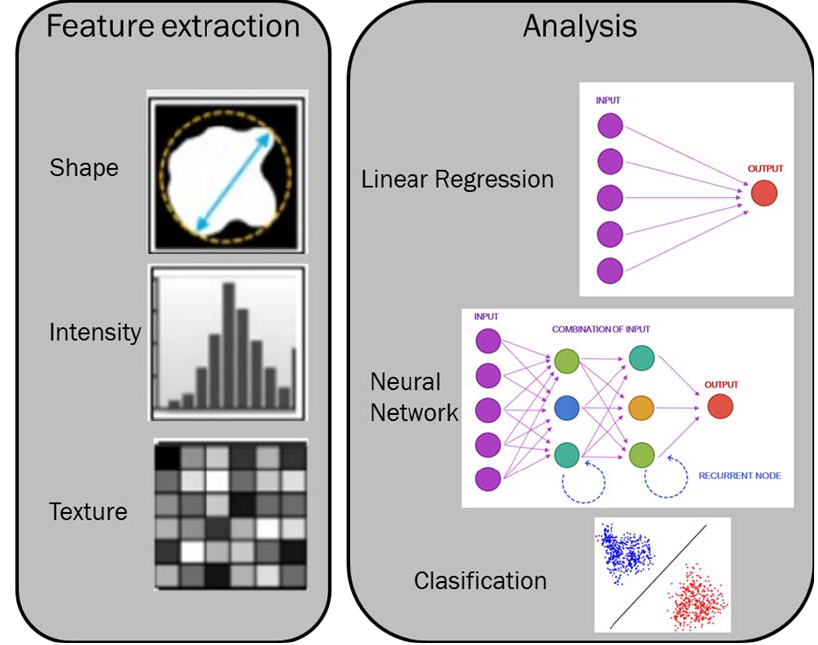
Figure 1. Representation of feature extraction and analysis in a radiomics process.